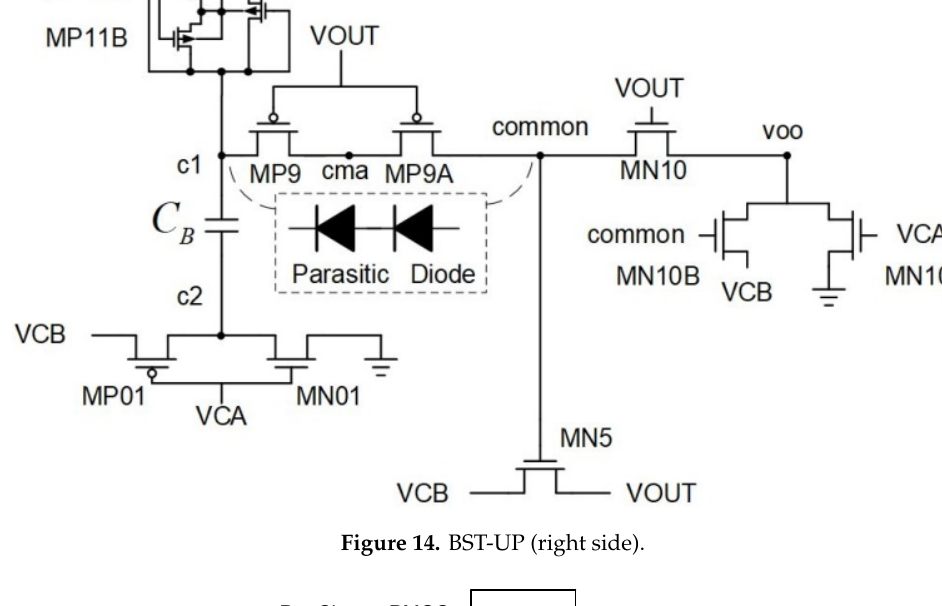
Figure 14. BST-UP (right side).